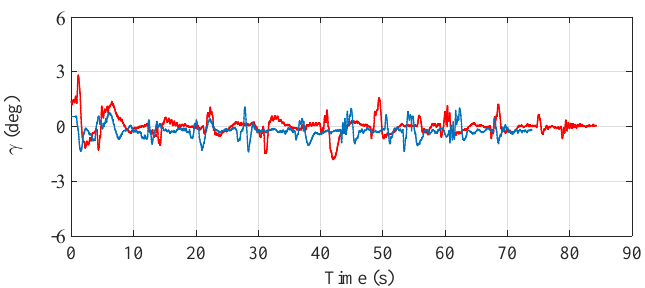
Figure 23. Inclination of the SCMS frame ( γ ) when the optimization is carried out with a α equal to one ( — ) and when the optimization is not considered ( — ).